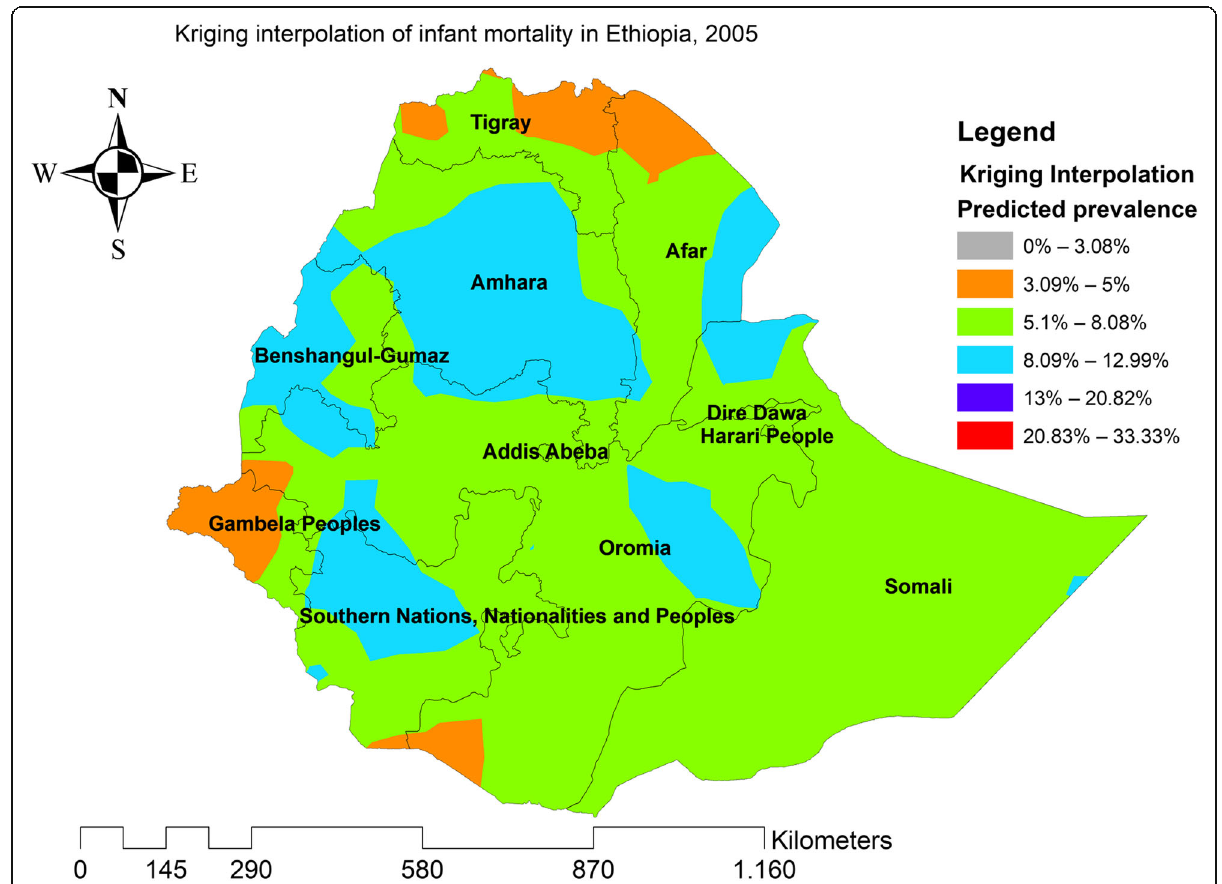
Fig. 7 The Kriging interpolation of infant mortality in Ethiopia